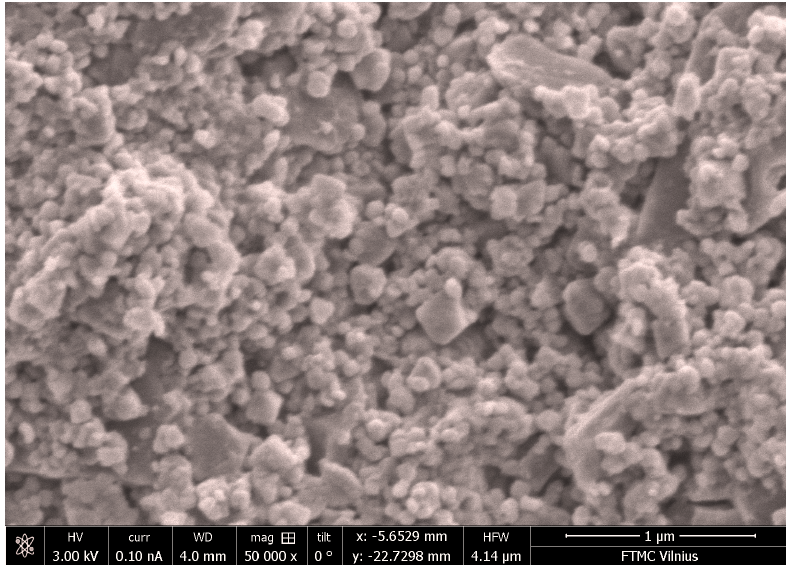
Figure 1. Scanning electron microscopy of the BTFO sample.